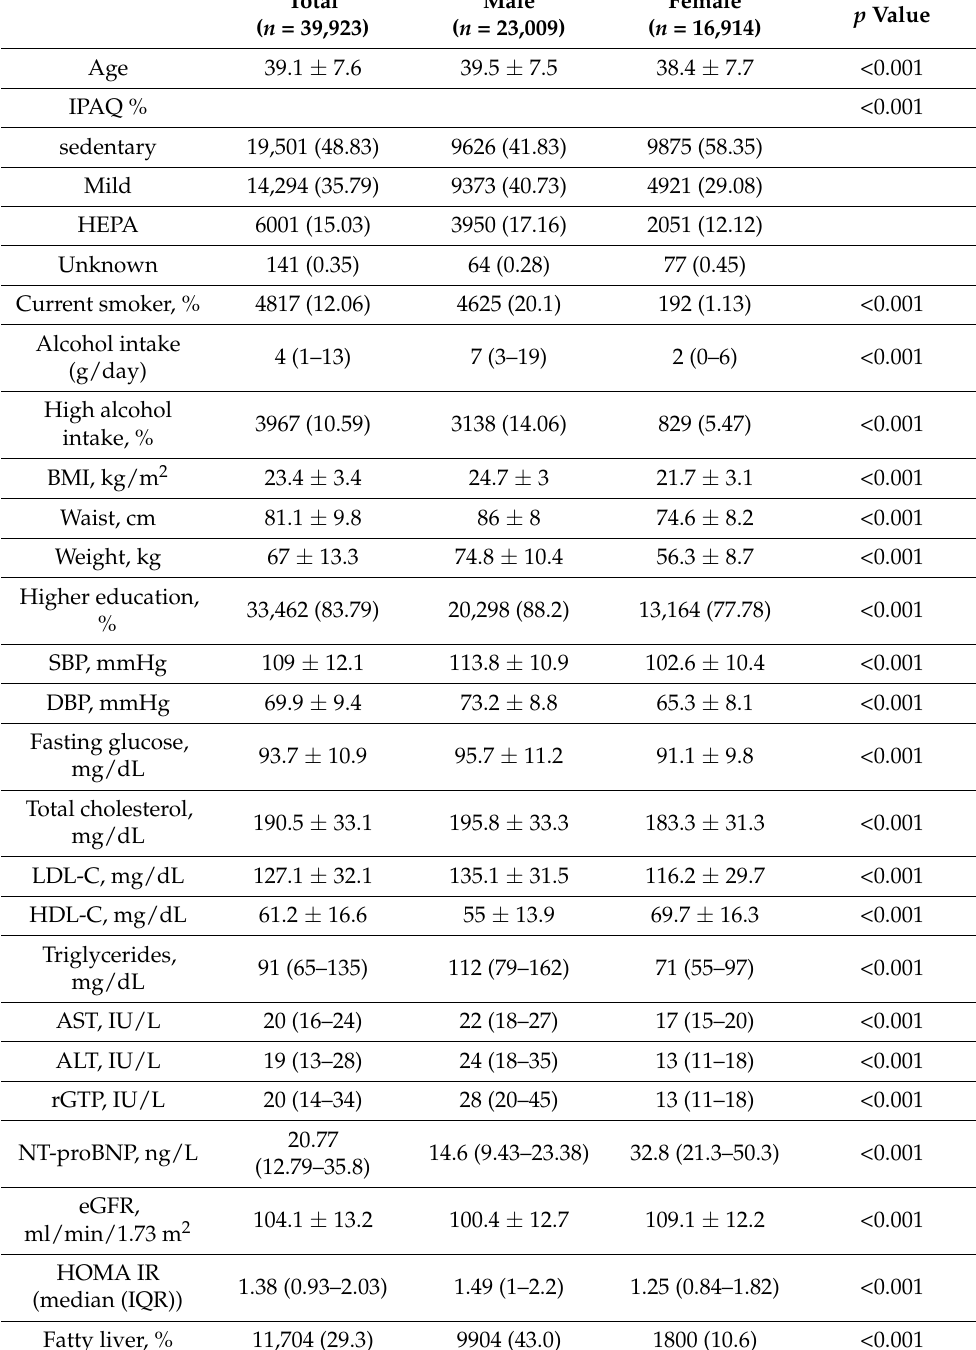
Table 3. Baseline characteristics according to